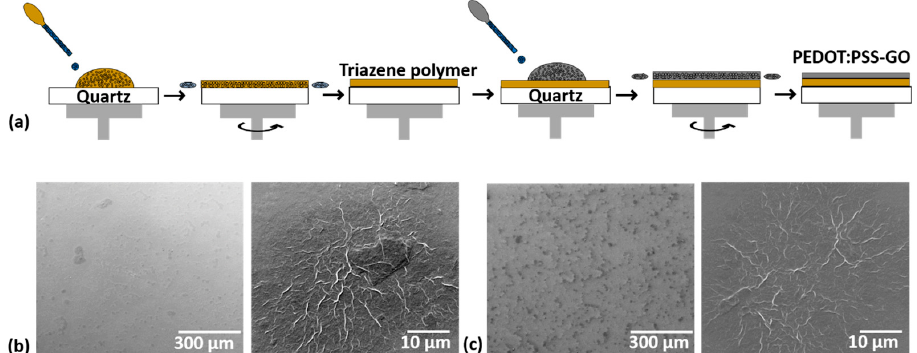
Figure 1. ( a ) Schematic representation of the experimental multilayer donor fabrication steps. In the case of single donor layer fabrication, the triazene polymer spin coating step is missing. Top-view SEM micrographs of PEDOT:PSS: GO layers with different concentrations ( b ) 25:75 wt.% and ( c ) 50:50 wt.% deposited by spin-coating on quartz.